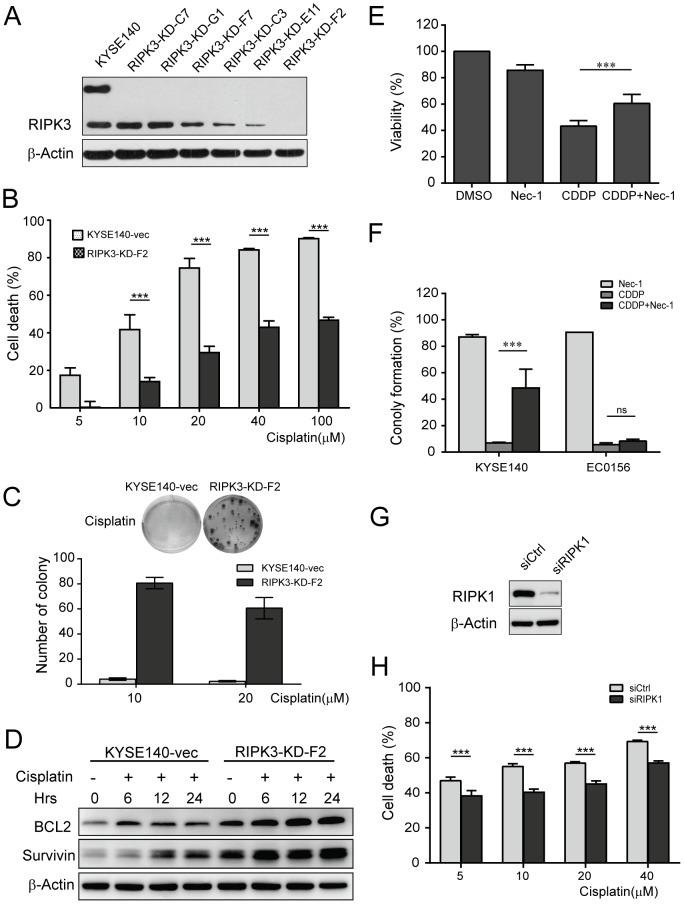
RIPK3 is required for cisplatin-induced necrosis.(A) Effects of RIPK3 knockdown were determined using western blot analysis, β-Actin as a loading control. (B) RIPK3-KD-F2 clones and the parental cells were treated with 10 µM cisplatin for 24 h. Cell viability was assessed by MTT assay. The data represent the mean percentage ± SD of cell death compared to parental cells. (C) The long-term viability of the cells was determined after cisplatin treatment for 6 h in RIPK3-KD cells using the colony formation assay. (D) Western blot analysis of Bcl-2 and survivin in the parental and RIPK3-KD-F2 cells after treatment with 10 µM cisplatin for 6, 12, or 24 h. β-Actin was used as a loading control. (E) KYSE140 cells were pre-incubated for 1 h with 20 µM Nec-1 or DMSO and then treated with 10 µM cisplatin for 24 h. Cell viability was determined using an MTT assay and is expressed as percentage of DMSO control. (F) KYSE140 and EC0156 cells were pre-incubated for 1 h with 20 µM Nec-1 or DMSO and then treated with 10 µM cisplatin for 24 h before medium was replaced with fresh medium. Colonies were identified using crystal violet staining and counted under the microscope. (G) Effects of RIPK1 knockdown were analyzed by western blotting, β-Actin as a loading control. (H) KYSE140 cells with RIPK1 siRNA were treated with the indicated concentrations of cisplatin for 24 h. The data represent the mean percentage ± SEM of cell death versus control cells.